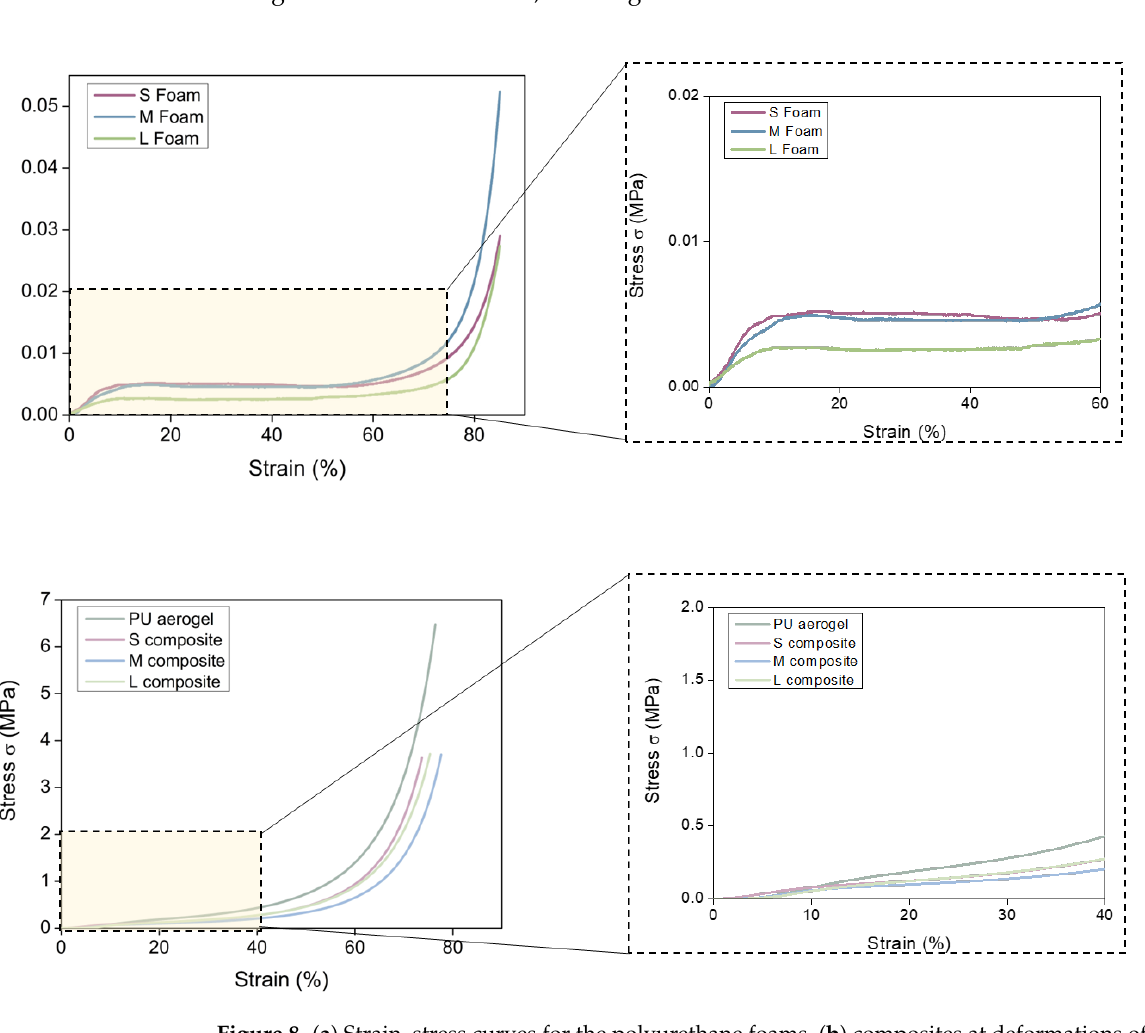
12 of 19 Figure 7. ( a ) Normalized elastic moduli for all the samples. ( b ) Stress at a strain of 10% for each compression – decompression cycle. Regarding the stress at a strain of 10% reached for each of the compression – decom- pression cycles, different behaviors are observed. Three groups can be differentiated in Figure 7 ’s right graph: the polyurethane foams with the lowest stress (values ca. 0.005 MPa) are, therefore, the softest samples (numerical values are gathered in Table S3). The